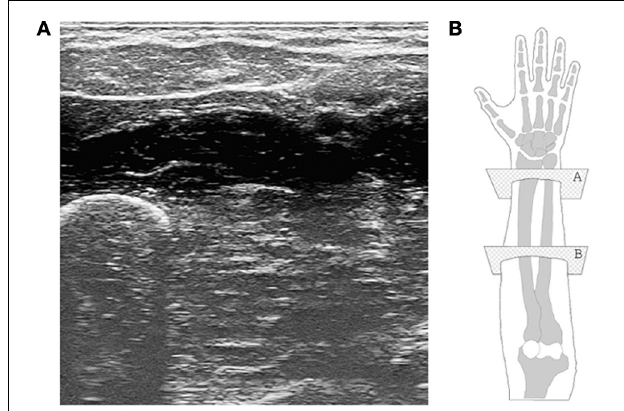
FIGURE 1 | (A) A typical ultrasound image obtained during the experiment. The ulna is clearly visible in the bottom-left corner, while the flexor muscles and tendons are seen in the upper part. (B) A graphical representation of the human hand and forearm (right forearm; dorsal side up). The transducer is placed onto the ventral side; plane “B” corresponds to the section from which the ultrasound image was